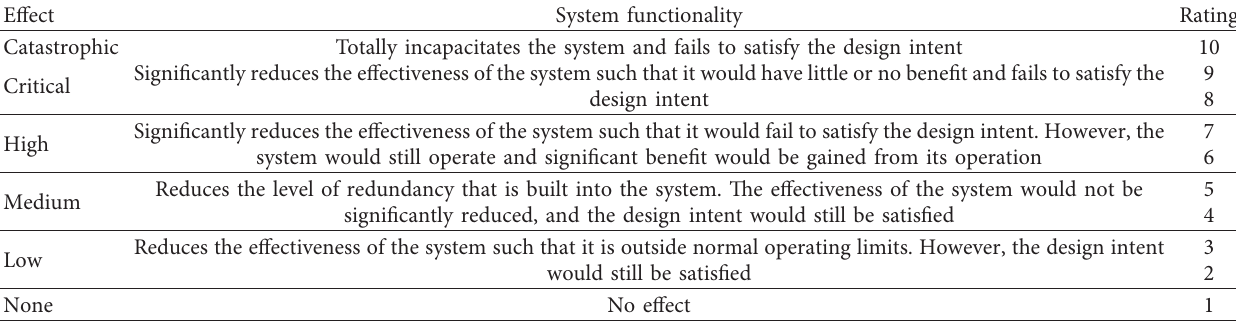
Table 1: Severity classification and description used in FMEA.